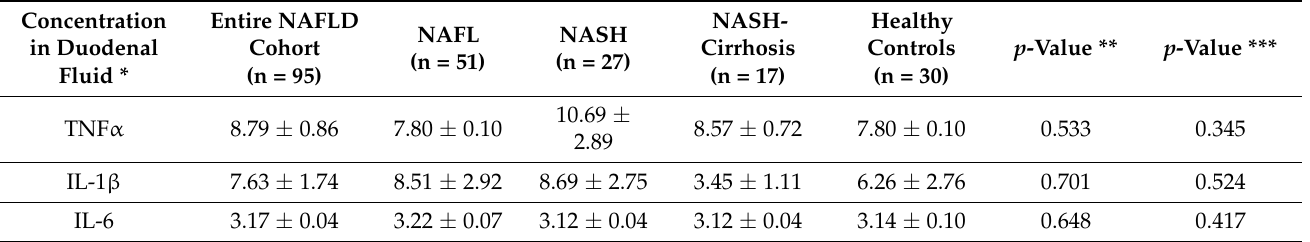
Table 3. TNF α , IL-1b, and IL-6 concentrations in duodenal fluid from the NAFLD cohort and healthy controls.